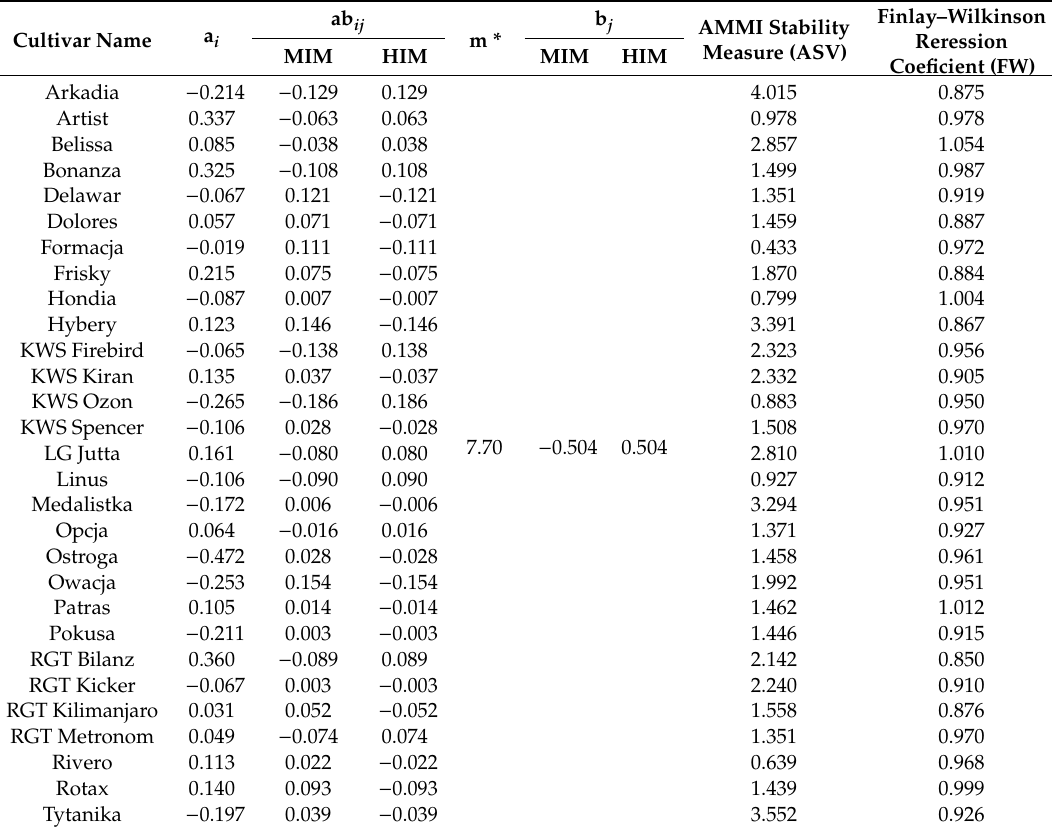
Table 3. The e ff ects of cultivar (a i ), management intensity level (b j ) and their interaction (ab ij ), the AMMI (additive main-e ff ects and multiplicative interaction) stability measure and the Finlay–Wilkinson regression coe ffi cient on winter wheat yield.